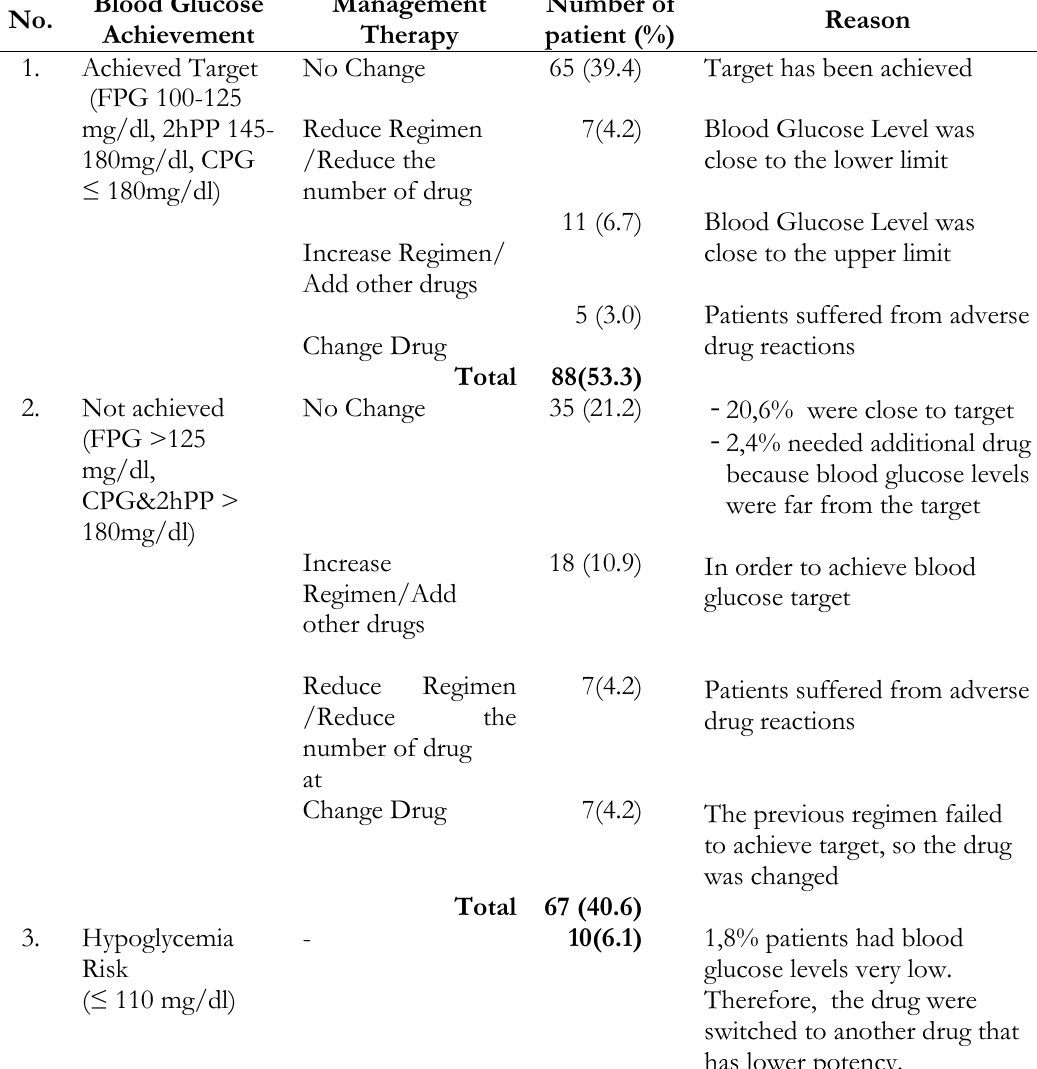
Table V. Blood glucose achievement of tipe 2 DM patients in geriatric outpatients Dr. Soetomo Hospital